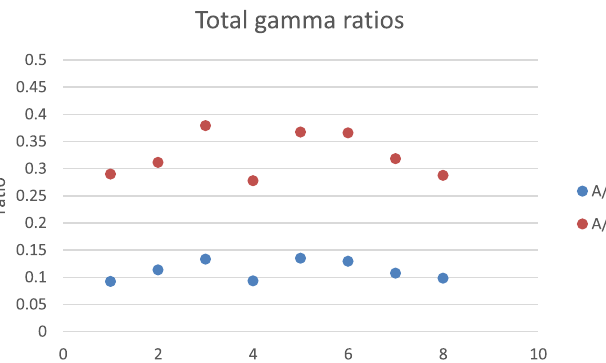
Fig. 8. Total gamma relative values, showing ratios between results from points A and C and A and B by the 8 different equipment used.